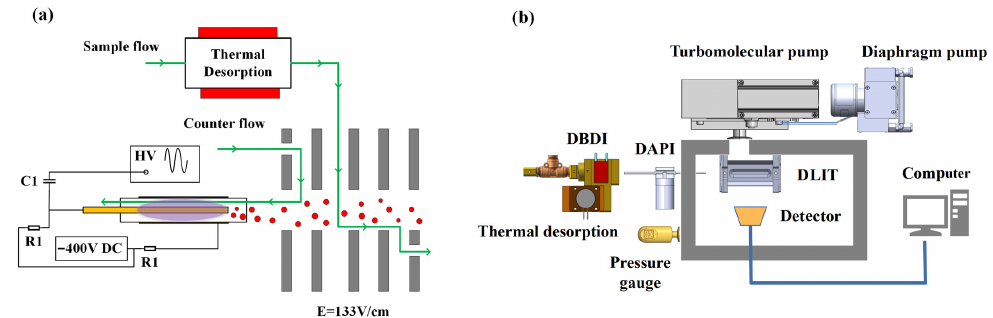
Figure 9. The schematic diagram of the homemade mass spectrometer. ( a ) The schematic design of the ionization and sampling design; ( b ) the schematic diagram of the platform